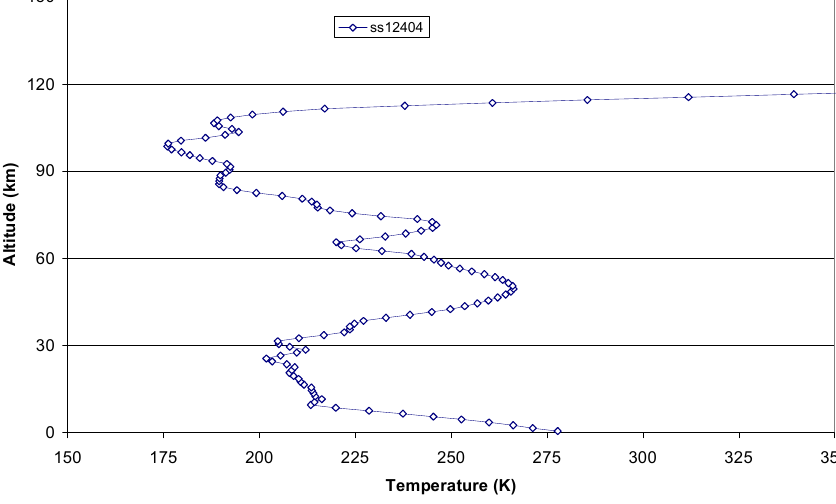
Fig. 2. A typical ACE-FTS temperature-altitude profile from the sunset occultation of orbit 12404 on 1 December 2005 at 15:48:56 (54.44 ◦ N, 4.13 ◦